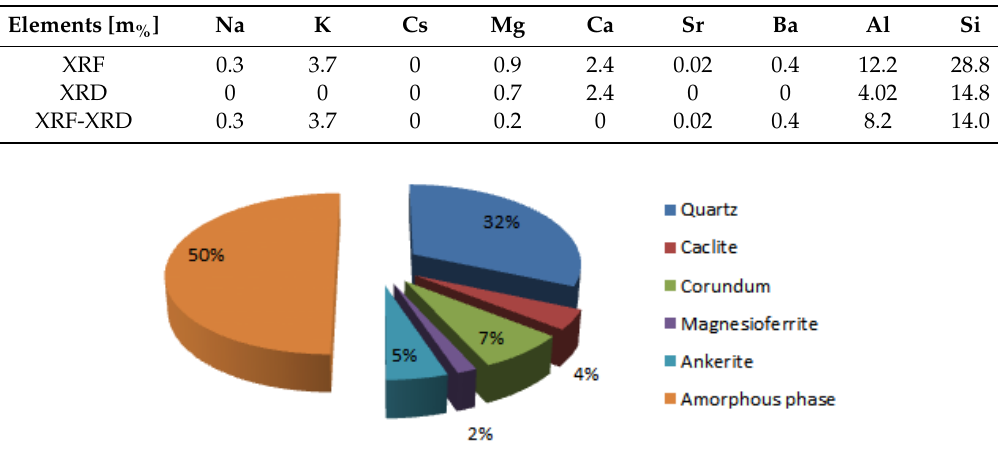
Figure 2. Mass percentage of minerals and amorphous phase in waste green ceramics determined from XRD measurement with Rietveld refinement with external standard.